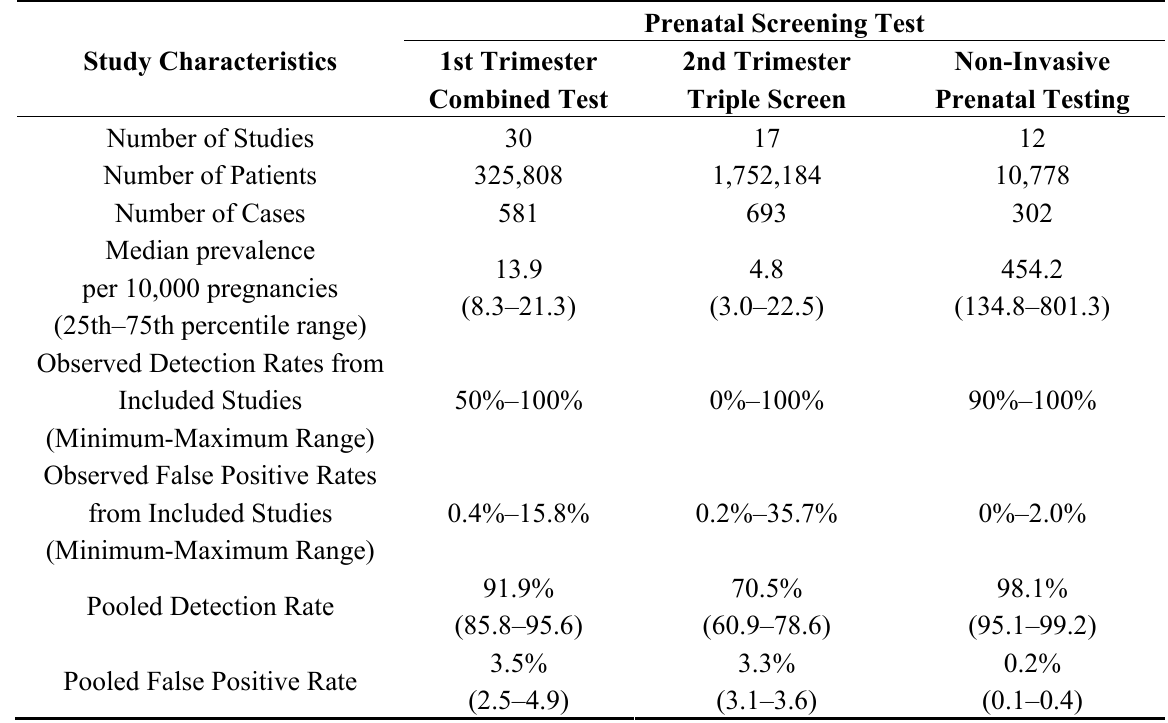
Table 3. Pooled results for trisomy